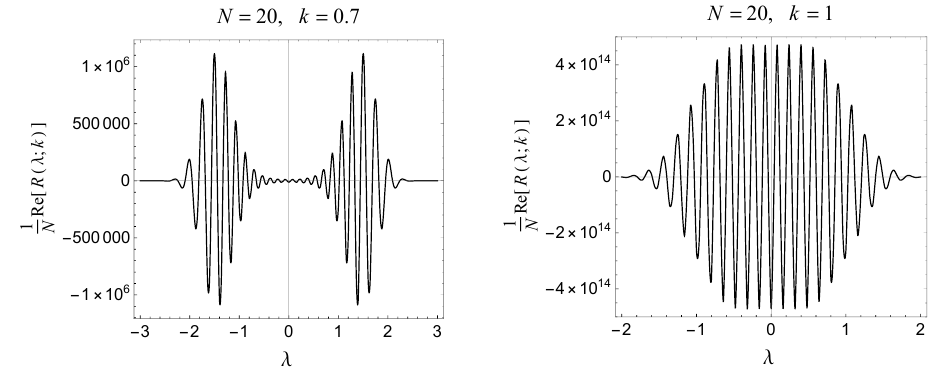
Figure 6 . The real part of the quenched spectral density for N = 20 at k = 0 : 7 and 1.